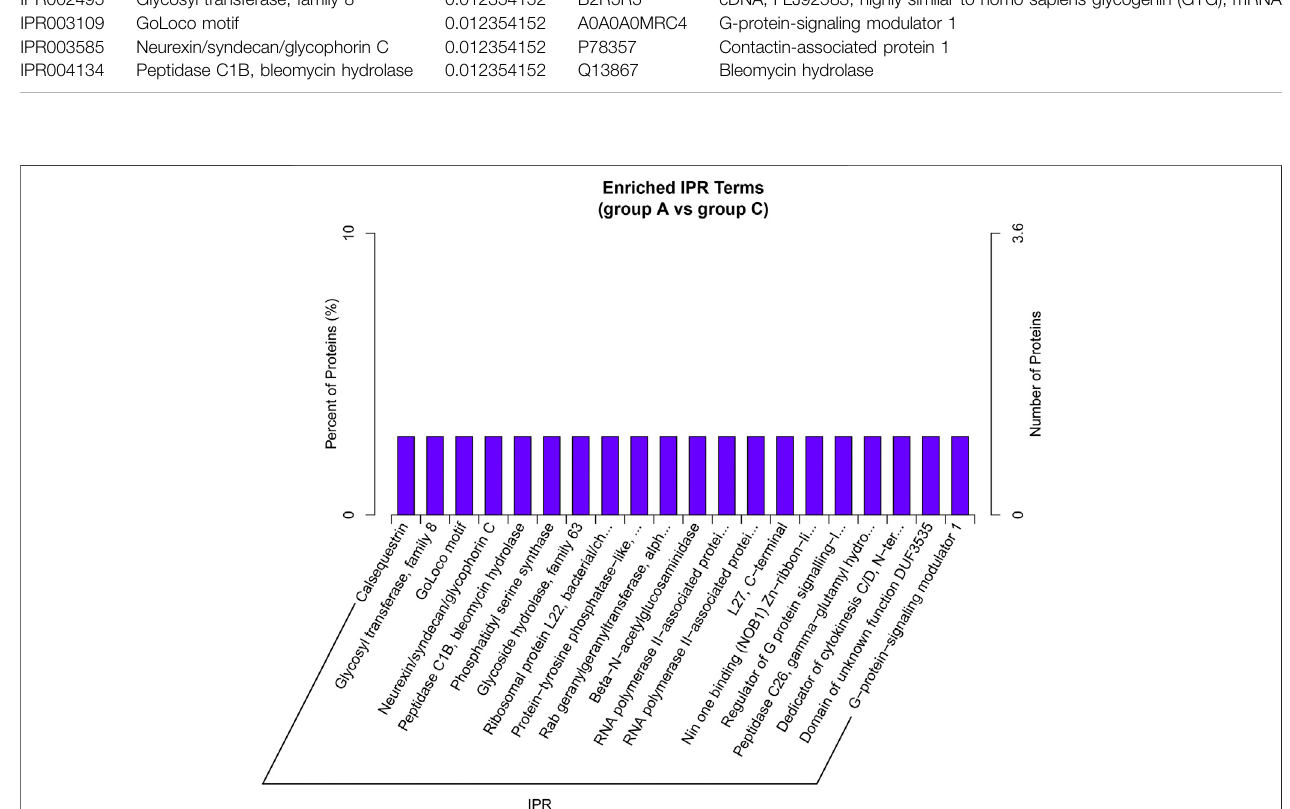
FIGURE7| IPRenrichmentanalysis.Atotalof47IPRtermswereidenti fi edbetweengroupAandgroupC.Thetop20IPRenrichmenttermsofallDEPwereshown in the bar plot. Each IPR terms has only one DEP enriched.